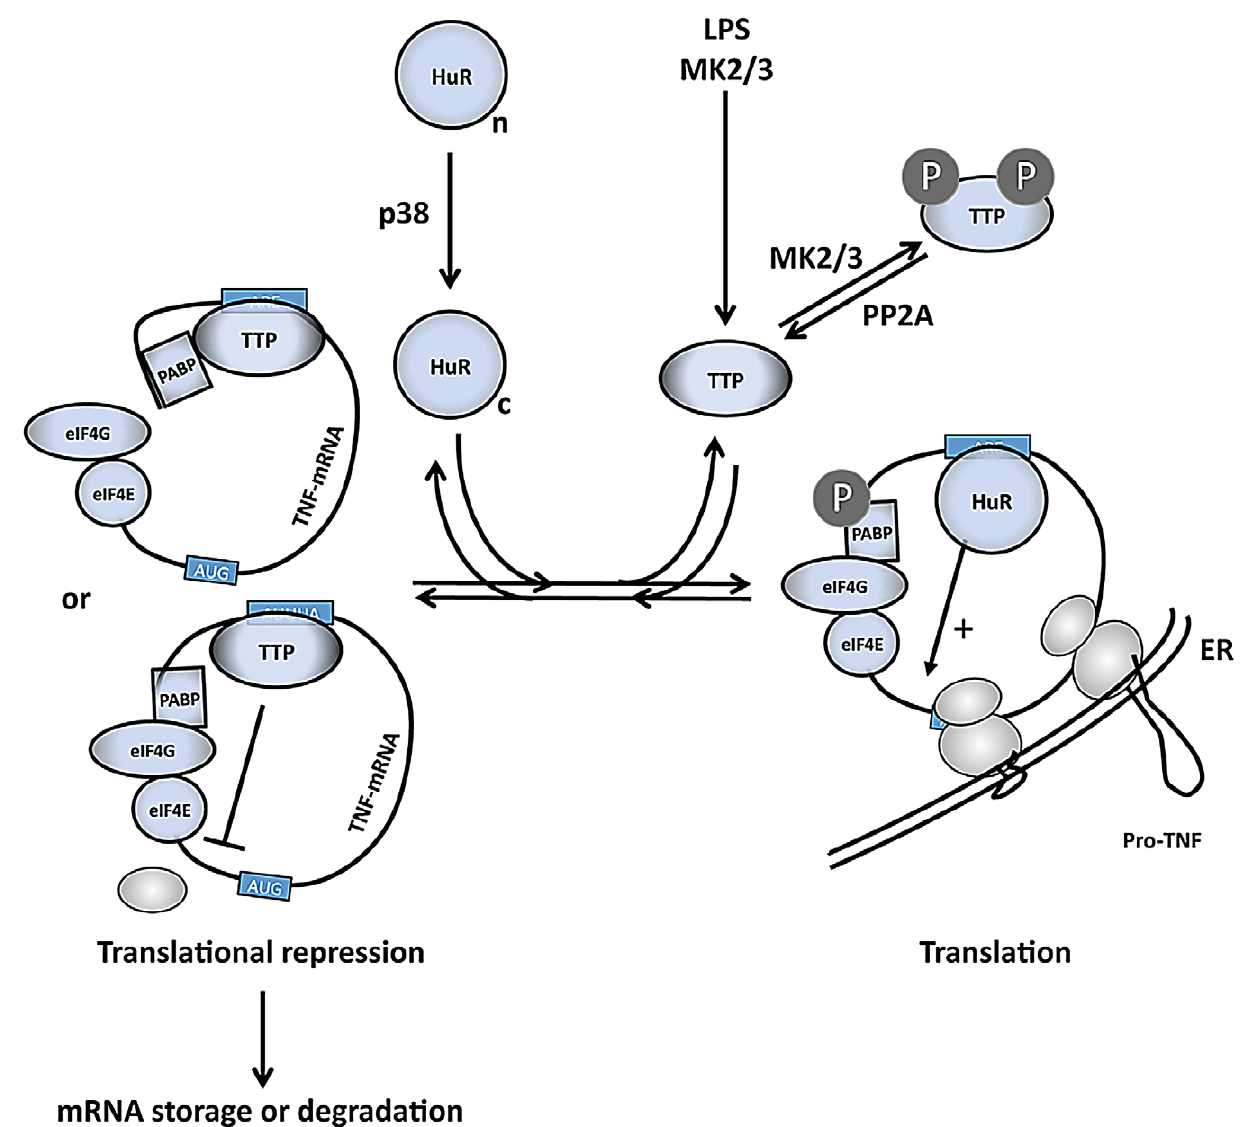
Figure 7. A comprehensive model of the regulation of TNF mRNA and TNF release by p38 and MK2/3. LPS induces expression of TTP and activates p38 and MK2/3. TTP and PABP1 are MK2 substrates [11,14,15], while HuR is a direct substrate for both p38 and MK2 and is shifted in its subcellular localization from the nuclear (n) to the cytoplasmic (c) compartment after phosphorylation [47,74]. HuR binds to the ARE and stimulates initiation of translation. Phosphorylation of TTP by MK2/3 impairs its capacity to compete with cytoplasmic HuR at the ARE in the 3 9 UTR of translational controlled mRNAs (right part of scheme). Without phosphorylation at its MK2/3 sites TTP replaces HuR and interferes with translational initiation by competition with eIF4G binding to PABP1 or by inhibition of binding of the 43S PIC. Thereby TTP limits expression of ARE-containing mRNAs, including its own mRNA, at later stages in the response (left part of scheme).